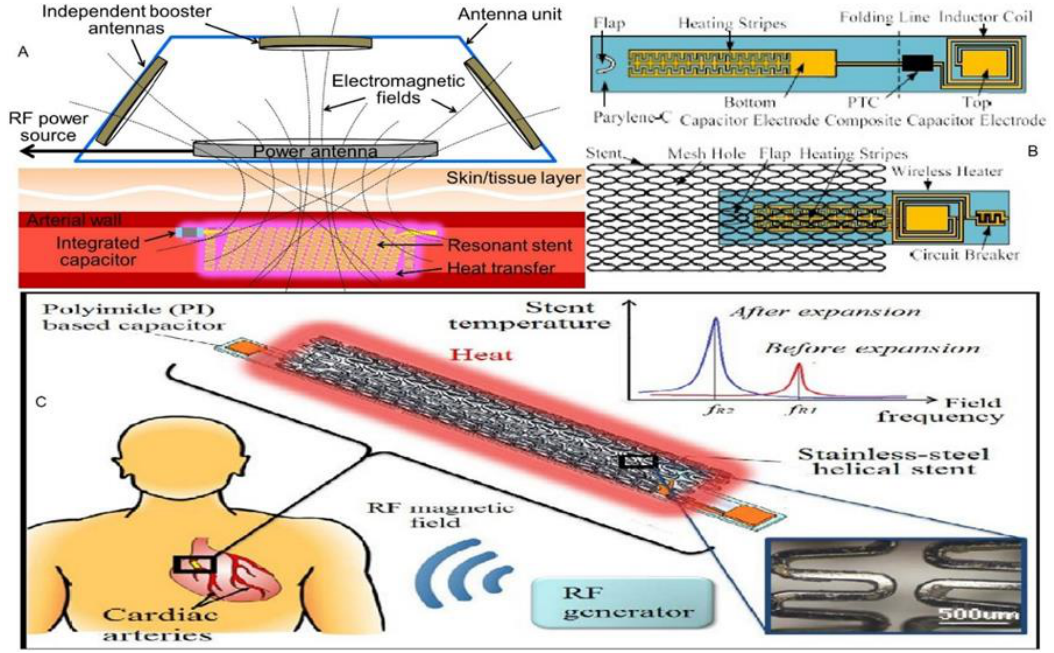
Figure 6. Hyperthermia treatment: ( A ) Conceptual diagram of the stent-based endohyperthermia system using the resonant-heating stent powered and operated using the external RF antenna unit with independent booster antennas. Reproduced with permission [96], copyright 2020, IEEE; ( B ) schematic of the proposed wireless micro heater. Reproduced with permission [97], copyright 2020, IEEE; ( C ) conceptual illustration of the stent-based wireless endohyperthermia for in-stent restenosis treatment. Reproduced with permission [98], copyright 2020, IEEE.